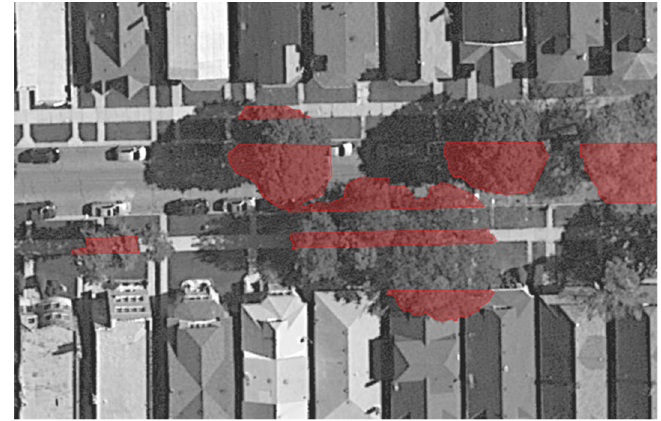
Figure 1. Graphic depicting areas of impervious pavement, sidewalk, and roof surfaces concealed by tree canopy. The areas shaded in red go undocumented by two-dimensional approach. Not to scale, for illustration only. Source: Google Earth, 2019. Illustration: by authors.